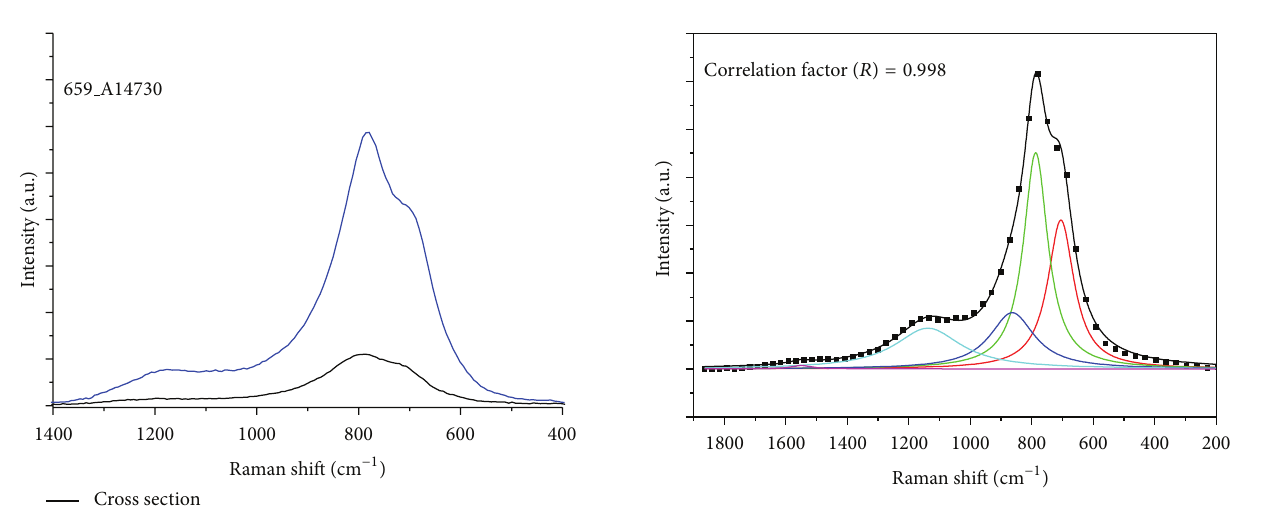
Figure 8: Raman spectrum of sample 659 A14730: deconvolutions with lorentzian